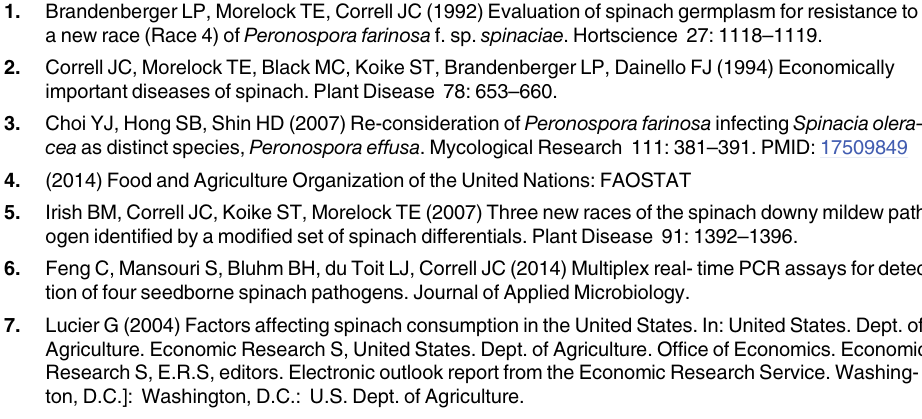
S1 Table. Primers and allele frequencies. S2 Table. Basic population genetic statistics for Peronospora effusa isolates. S3 Table. Analysis of molecular variance